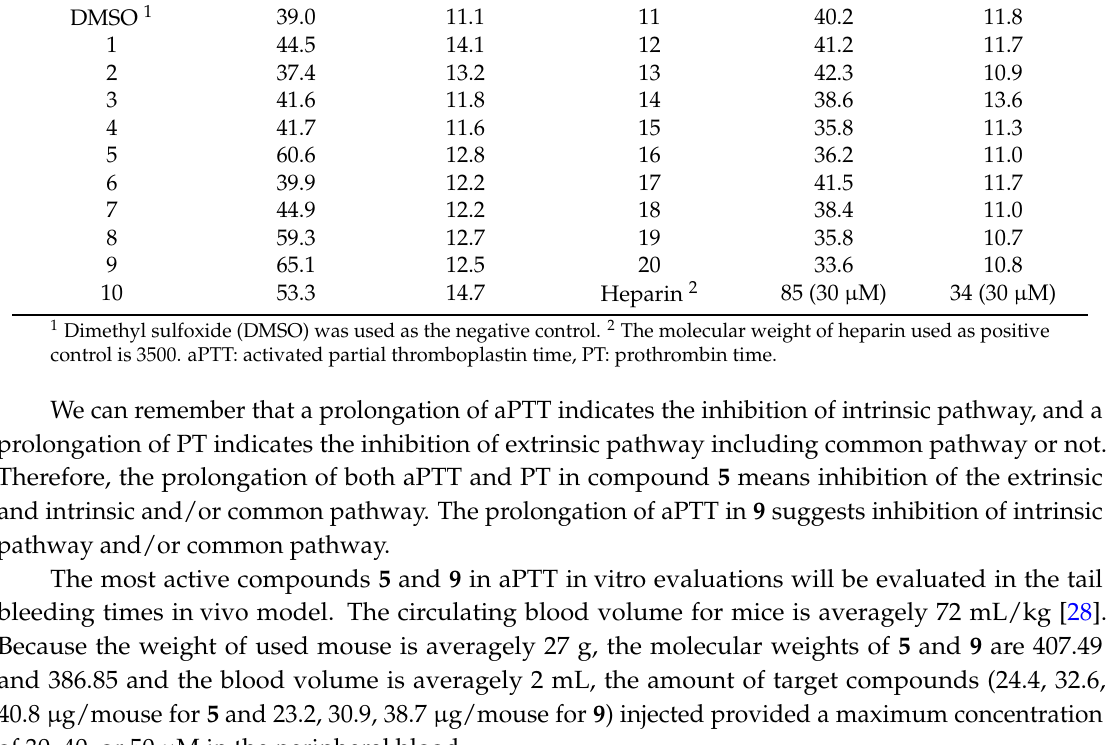
Table 1. Anticoagulant activities of non-amidine compounds 1 – 20 at 30 µ g/mL. Compound No.